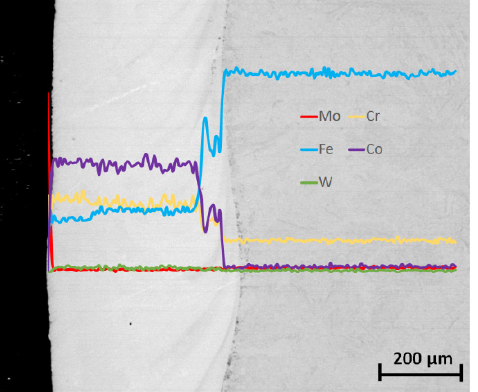
Figure 4. The results of the EDS linear chemical composition analysis of Co-6 coating specimen #4 (according to Table